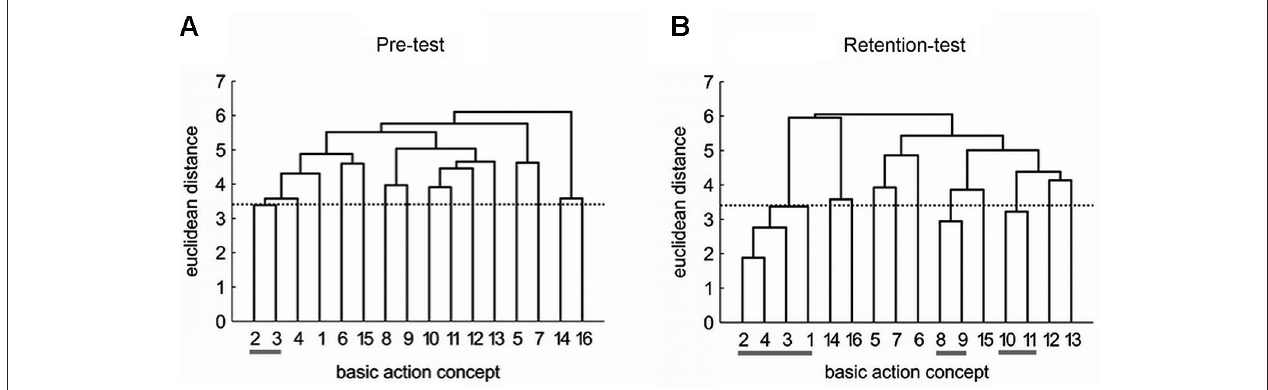
shoulders parallel to target line, (2) align club face square to target line, (3) grip check, (4) look to the hole, (5) rotate shoulders away from the ball, (6) keep arms-shoulder triangle, (7) smooth transition, (8) rotate shoulders towards the ball, (9) accelerate club, (10) impact with the ball, (11) club face square to target line at impact, (12) follow-through, (13) rotate shoulders through the ball, (14) decelerate club, (15) direct clubhead to planned position, and (16) look to the outcome [Reprinted from Frank et al., 2013, with